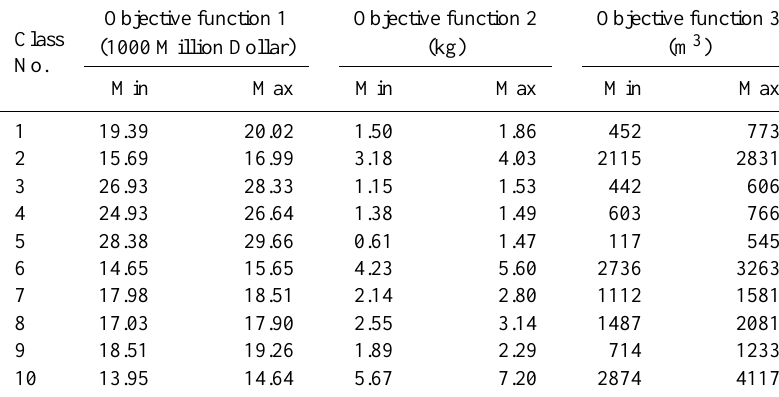
Table 7. Range of variation of objective functions in each class.